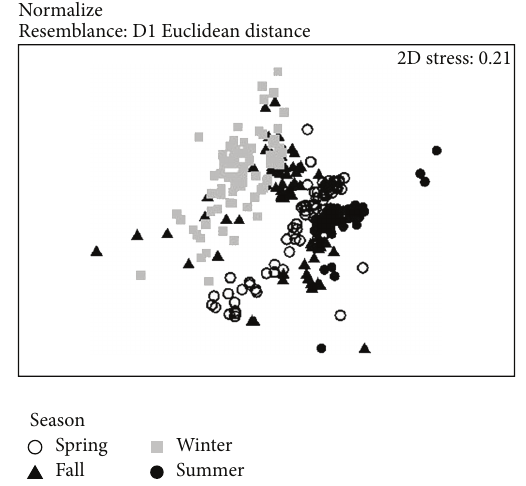
Figure 2: nMDS ordination of water quality parameters for the study area. Temperature, dissolved oxygen, nitrite, nitrate, ammo- nium, ortophosphate, and chlorophyll 𝑎 , were included in the multivariate analysis.